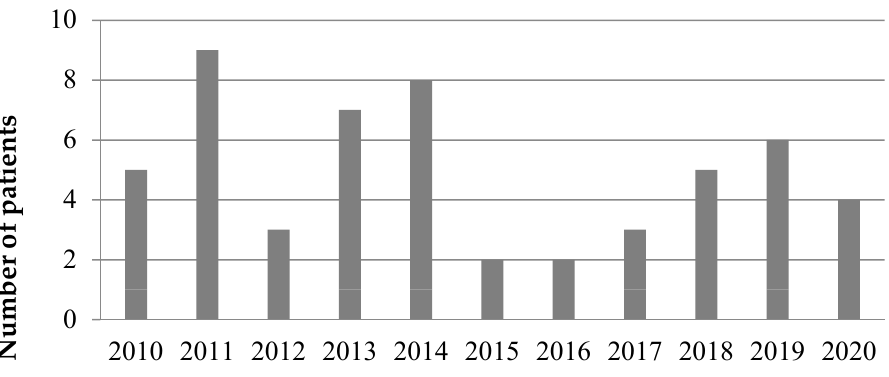
Figure 2. Distribution of the number of cases according to year of initial visit.